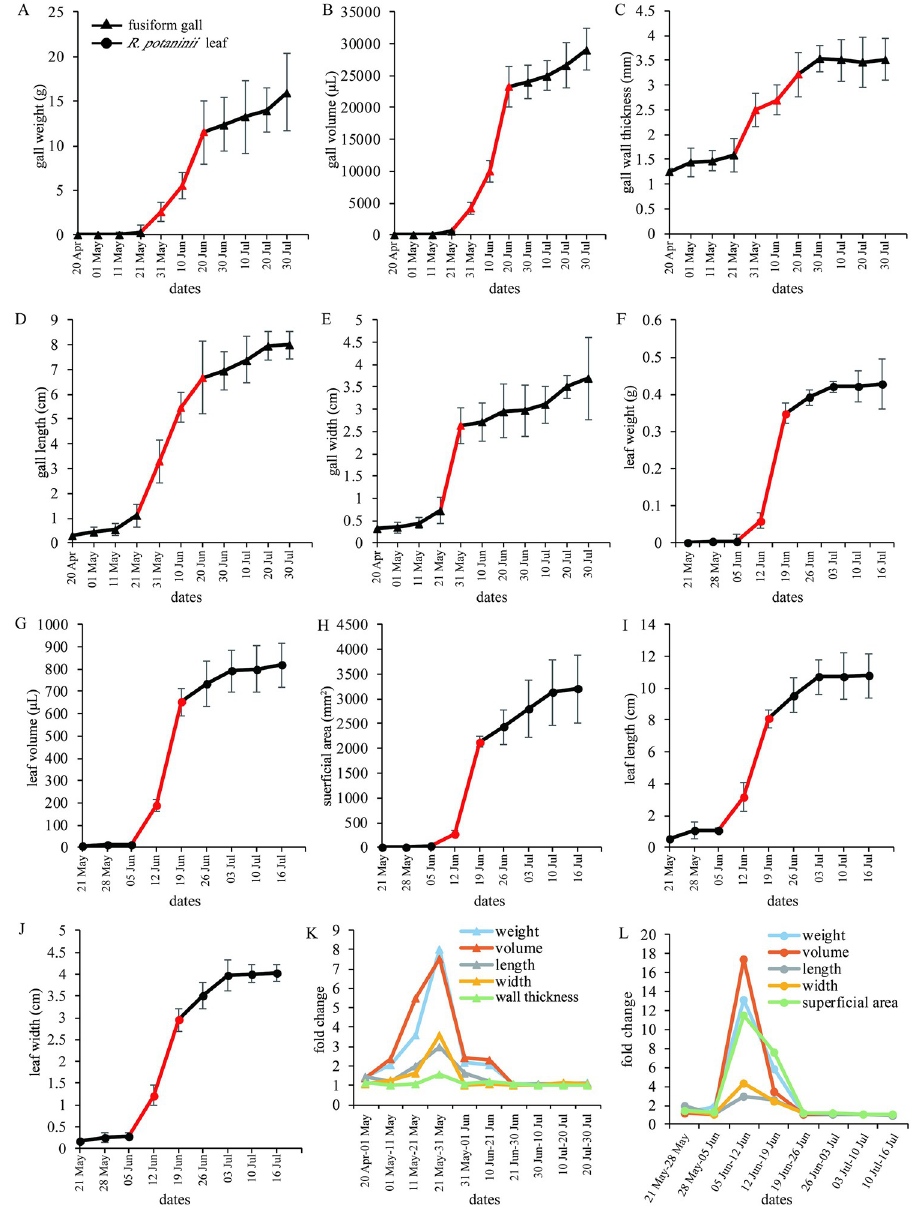
Fig 2. Developmental parameters of fusiform galls and R . potaninii leaflets. (A-E) Weight, volume, thickness, length, and width of fusiform galls during developmental stage, respectively. (F-J) Weight, volume, superficial area, length, and width of R . potaninii leaflets during developmental stage, respectively. (K-L) Fold change of developmental parameters of fusiform galls and R . potaninii leaflets. Growth curves indicate that development could be divided into initial, rapid growth, and slow growth stages. X axis of indicates the data of sample collection; red lines indicate rapid growth periods. galls and 5 to 19 June for R . potaninii leaflets), the length and width of fusiform galls increased by an average of five times, and the weight and volume increased by 39 and 43 times, respec- tively. The length and width of R . potaninii leaflets increased by an average of nine times, and the weight and volume increased by an average of 74 and 61 times, respectively.